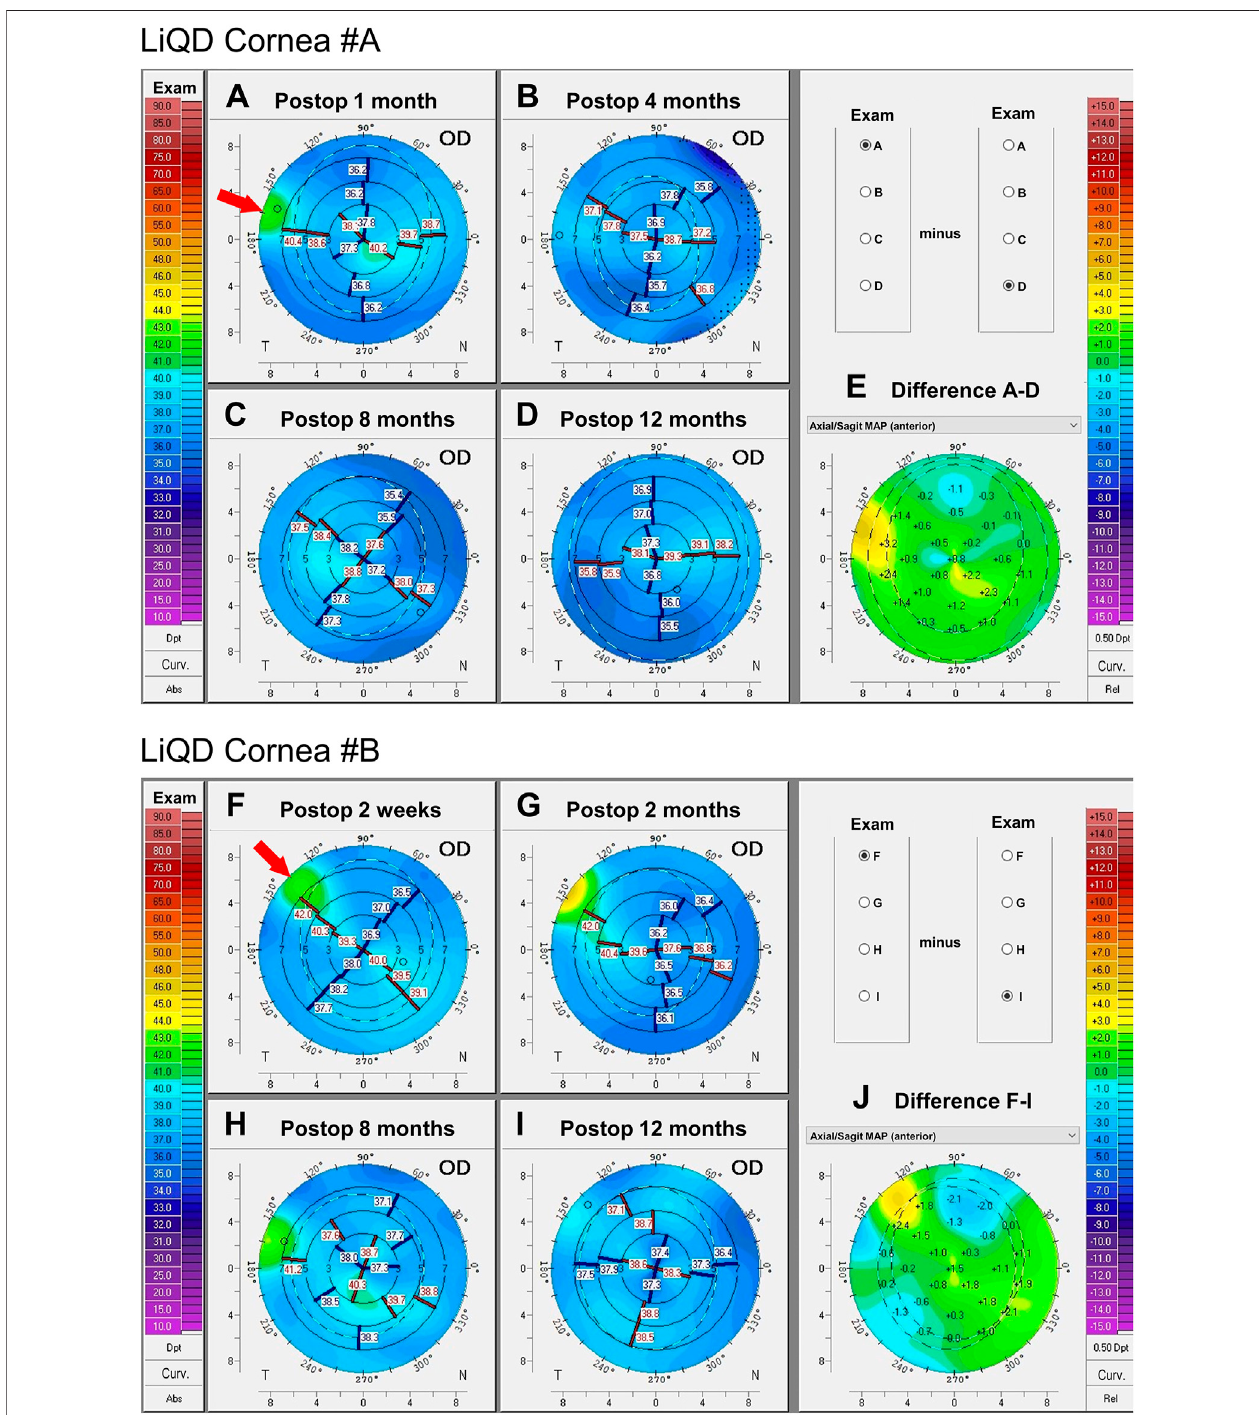
FIGURE 7 | Corneal tomography: Animal #A. Serial sagittal curvature maps of animal #A ’ s implanted cornea at 1, 4, 8, and 12 months postoperatively (A – D) . Smoothing of the corneal anterior surface is summarized by the difference map in (E) . Animal #B. Serial sagittal curvature maps of animal #B ’ s implanted cornea at 2 weeks, and 2, 8, and 12 months after surgery (F – I) . Smoothing of the corneal anterior surface is summarized in (J) . The arrows indicate the implanted regions.